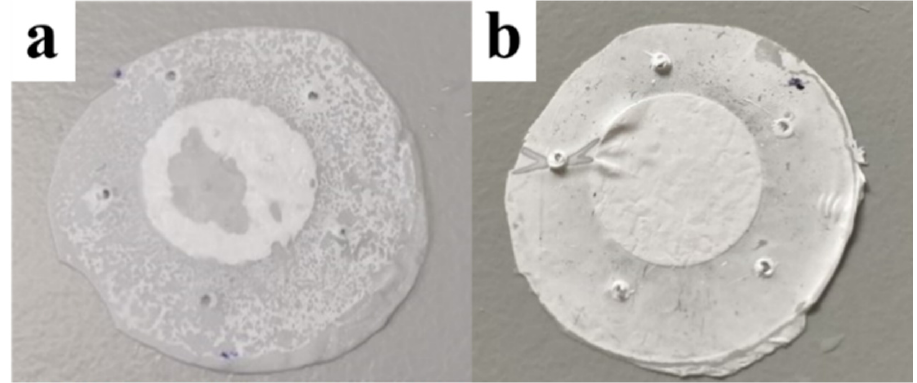
Figure 8. A typical example of a wetted area on the surface of ( a ) a 10% membrane and ( b ) a 5% membrane after 48 h solute transport experiments.